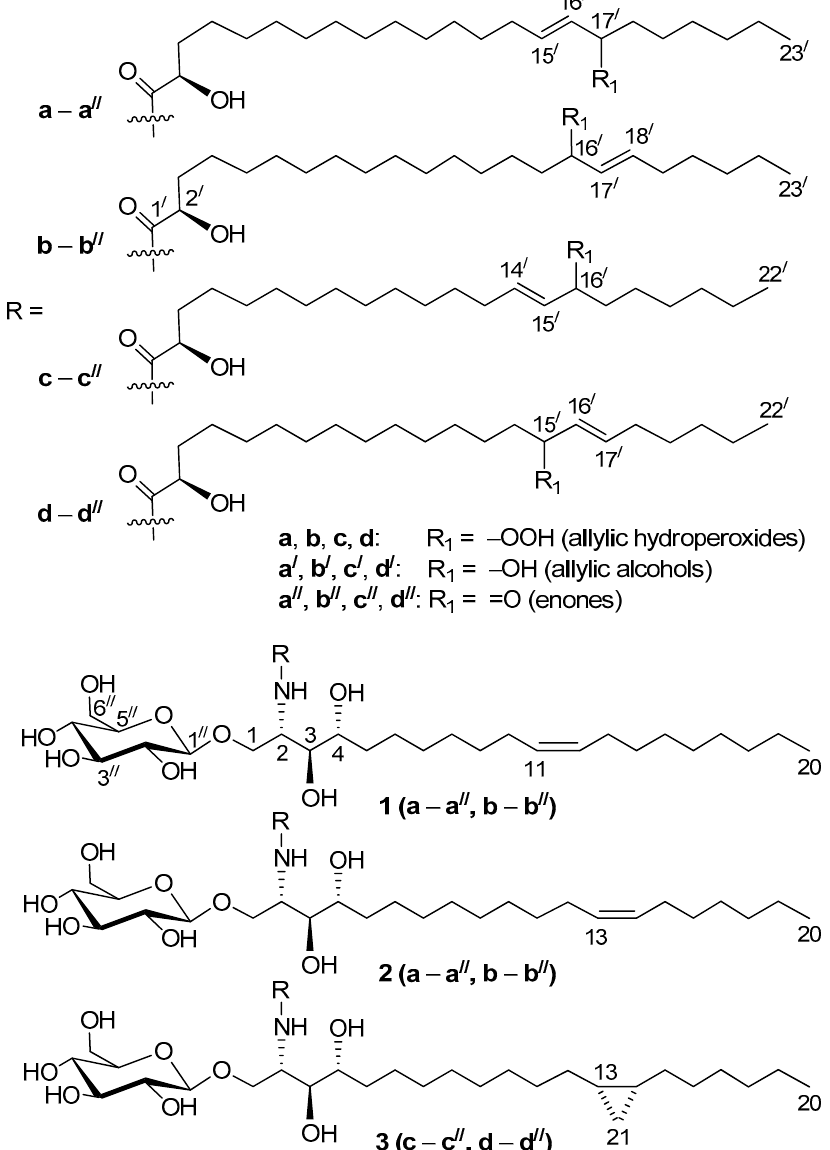
Figure 1. Oxidized cerebrosides from the extract of a sponge Aulosaccus sp.